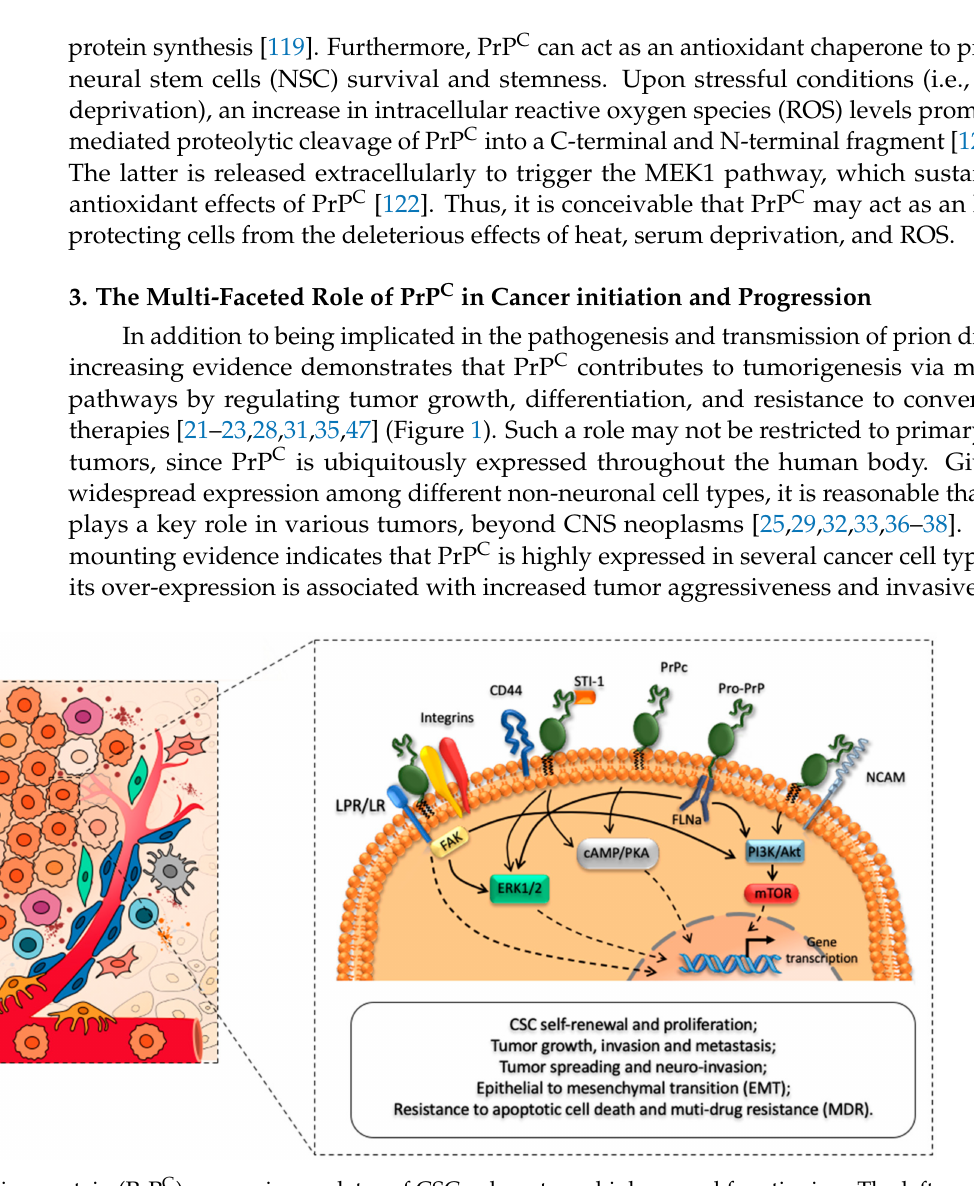
Figure 1. Cellular prion protein (PrP C ) as a main regulator of CSCs phenotype, biology, and functioning. The left panel of the cartoon depicts the cross-talk between cancer stem cells (CSCs) and major cellular components (i.e., endothelial cells, fibroblasts, pericytes, macrophages, and T cells) of the tumor micro-environment (TME). The right panel schematizes the role of PrP C in promoting CSC self-renewal, proliferation, and migration. In addition, PrP C interacts with several receptors and cell surface proteins to modulate CSCs’ tumor-initiating and metastatic capacities, while promoting increased therapeutic resistance. In this way, it modulates tumor growth, survival, infiltration, and multi-drug